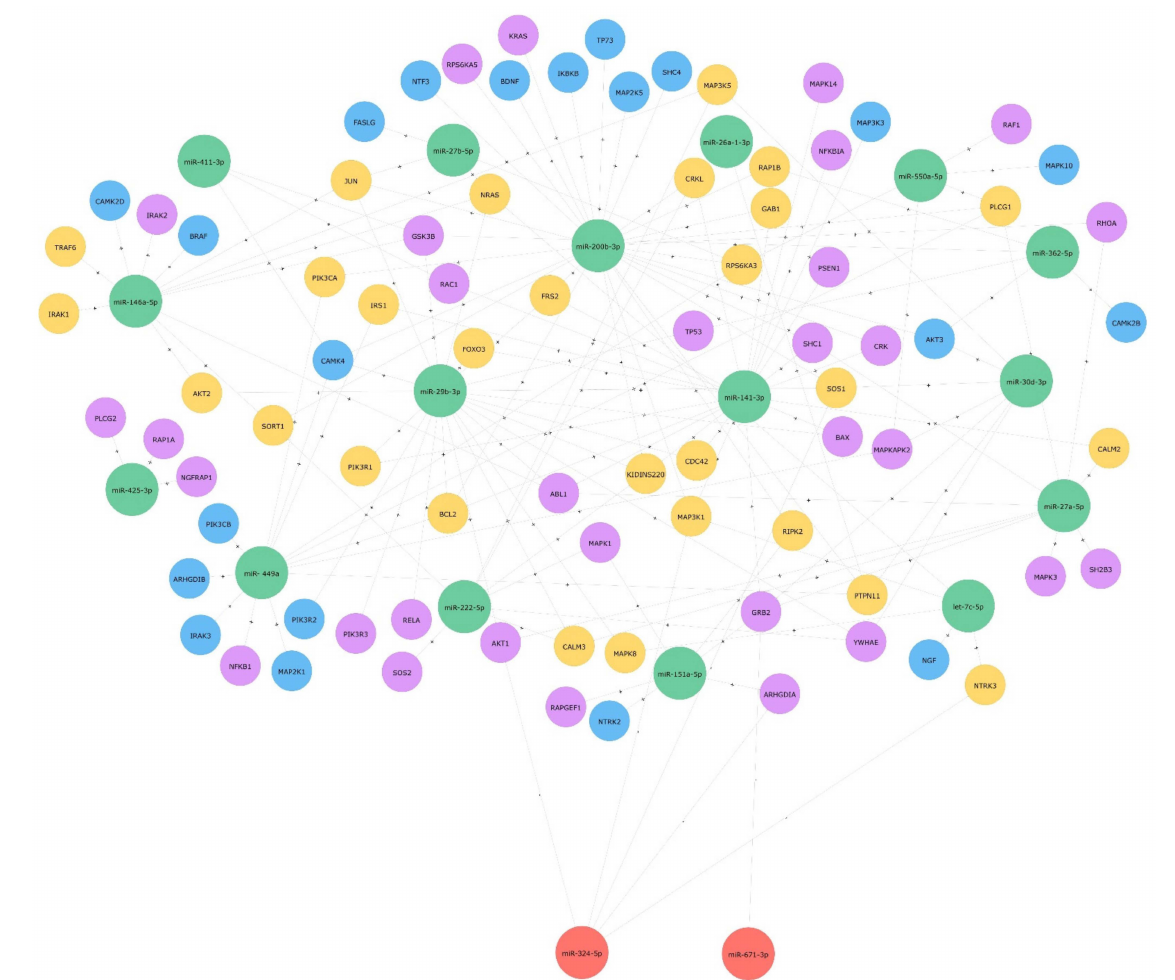
Figure 2. MiRNA-target genes interactions in neurotrophin signaling pathway. Neo4J graph of relationships between significant miRNAs and target genes. Colors of nodes as follows: green: hypo- expressed miRNAs; red: hyper-expressed miRNAs; blue: predicted target genes from DIANA-microT analysis; violet: experimentally supported target genes from DIANA-TarBase analysis; yellow: target genes identified by both DIANA-microT and TarBase analysis. Symbols as follows: +: induction of target gene upregulation; − : induction of target gene